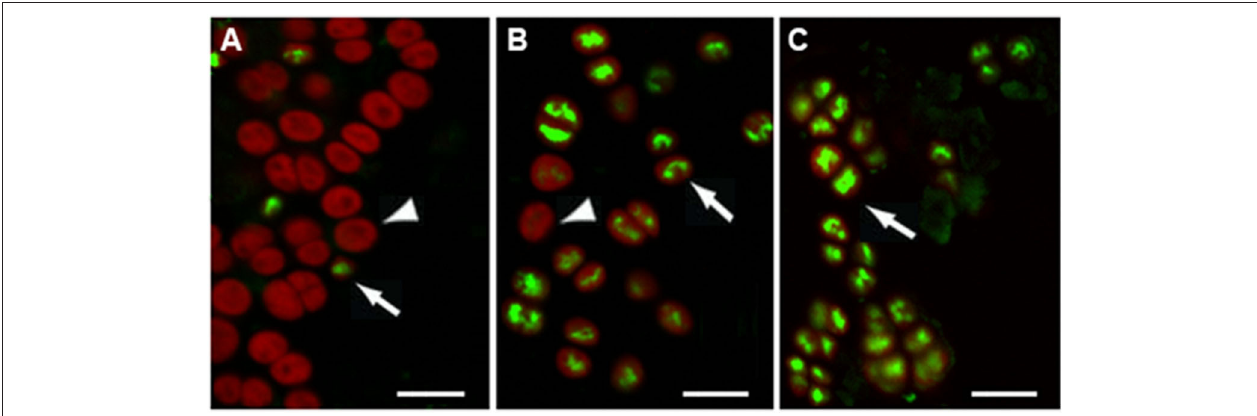
FIGURE 4 | Viability of 7-year dried Chroococcidiopsis biofilms mixed with P-MRS exposed to increasing Mars-like UV radiation doses, according to SYTOX-Green staining. Liquid control cultures showing live, SYTOX-Green-negative cells (arrowhead) and a few dead, SYTOX-green-positive cells (arrow) (A) ; dried biofilms exposed to 5.5 × 10 3 kJ/m 2 showing live, SYTOX-negative cells (arrowhead); (B) ; biofilms exposed to 5.5 × 10 5 kJ/m ² showing dead, SYTOX-green positive cells with SYTOX-green stained nucleoids (arrow) and chlorophyll autofluorescence (C) . Scale bar = 10 µ